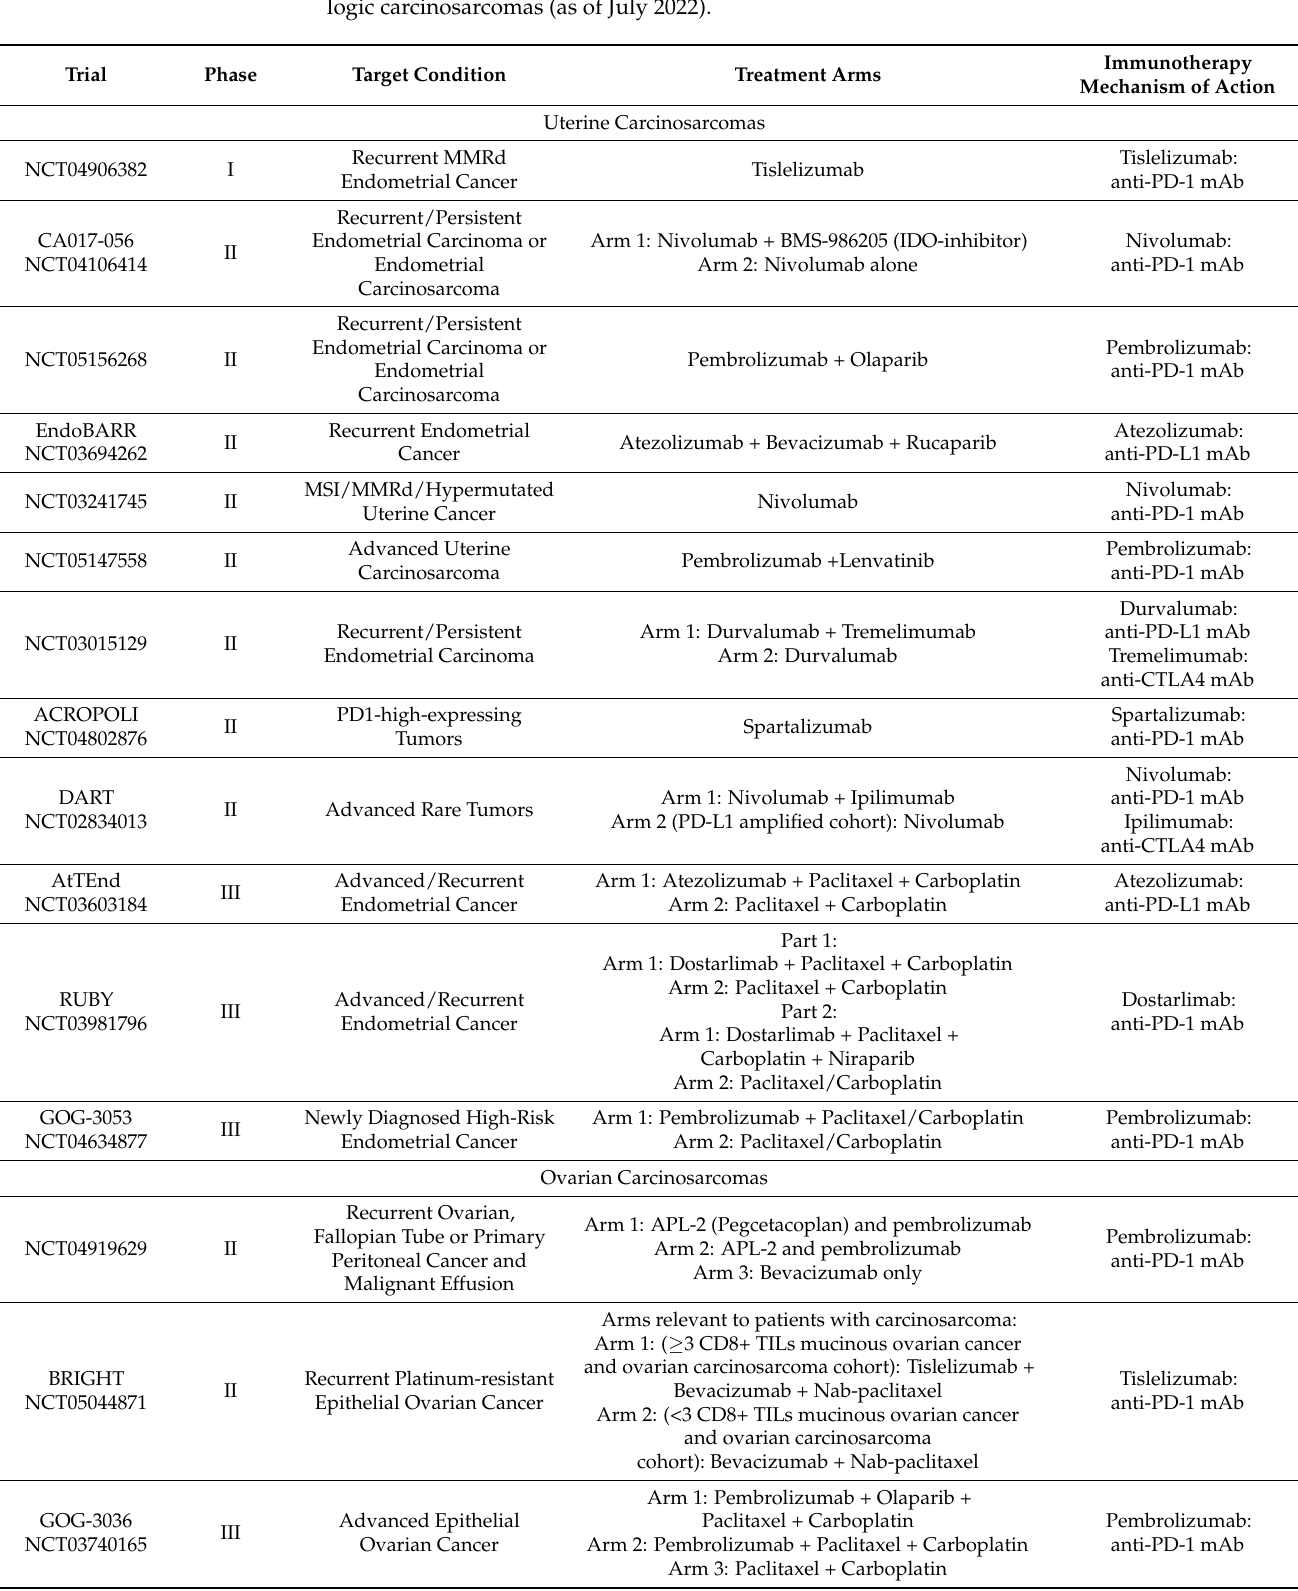
Table 2. Selection of ongoing immunotherapy clinical trials open to accrual of patients with gyneco- logic carcinosarcomas (as of July